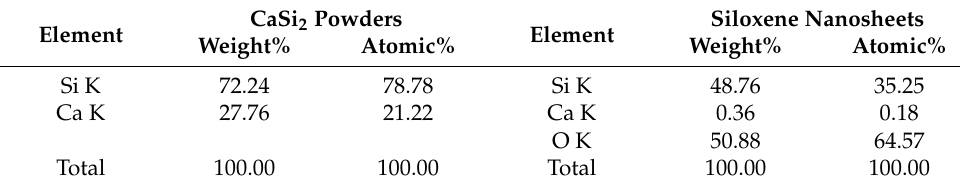
Figure 2. The element distribution of CaSi 2 and siloxene nanosheets. ( a – c ) EDS images of CaSi 2 , ( d – g ) TEM mapping images of siloxene nanosheets. Table 1. Element content of CaSi 2 powders and siloxene